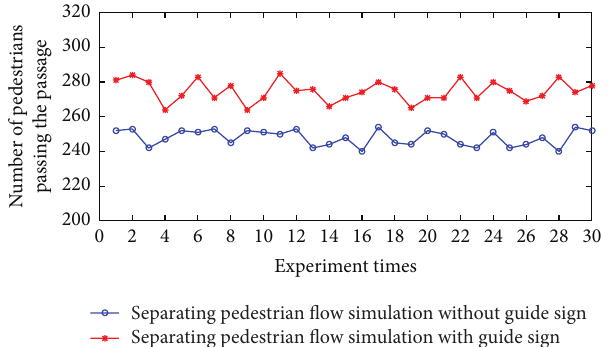
Figure 9: The number of pedestrians passing the passage without and with guide